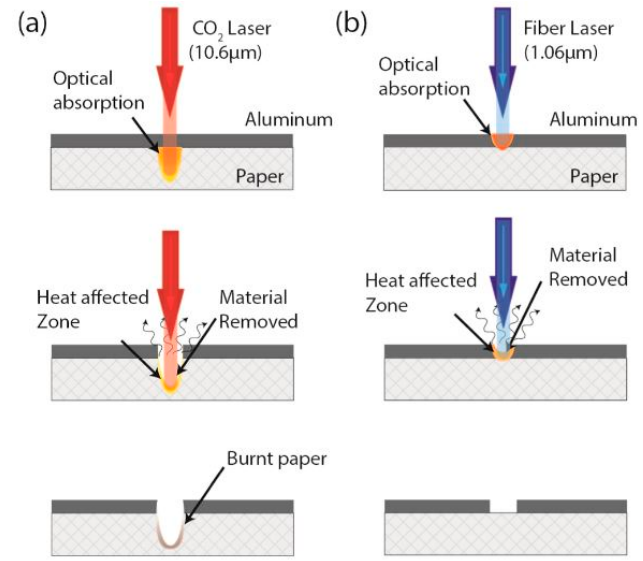
Figure 8. Illustration of the laser ablation of a thin aluminum layer on metalized paper (MP) using ( a ) indirect laser ablation (ILA) using CO 2 laser and ( b ) direct laser ablation (DLA) using Nd: YAG laser. Reproduced from Rahimi, R., Ochoa, M. and Ziaie, B., 2018. Comparison of Direct and Indirect Laser